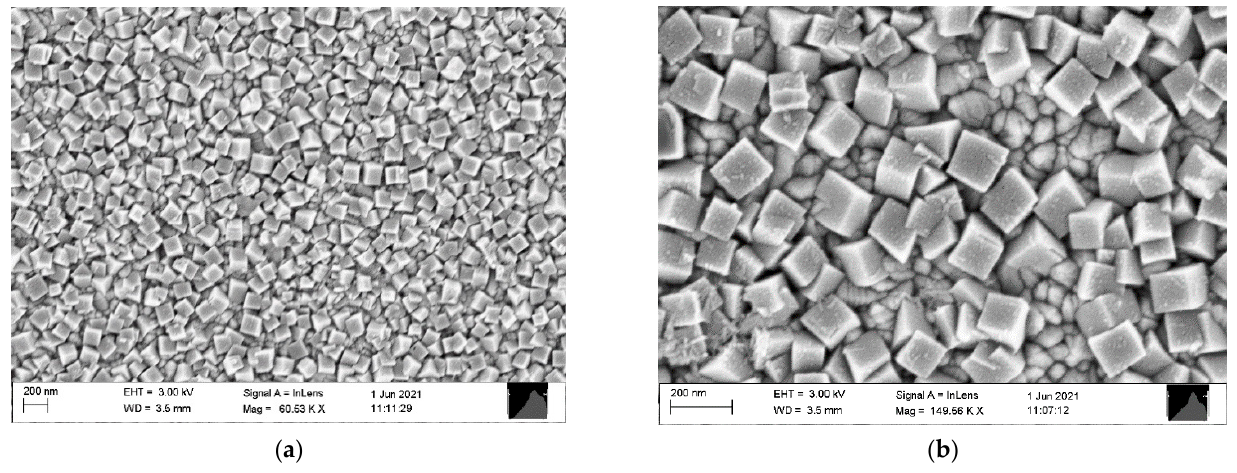
Figure 3. SEM image of the Cu 2 O substrate after 15 min of deposition at pH 10 and − 0.35 V vs. Ag/AgCl in two different magnifications. ( a ) low magnification image ( b ) high magnification image.